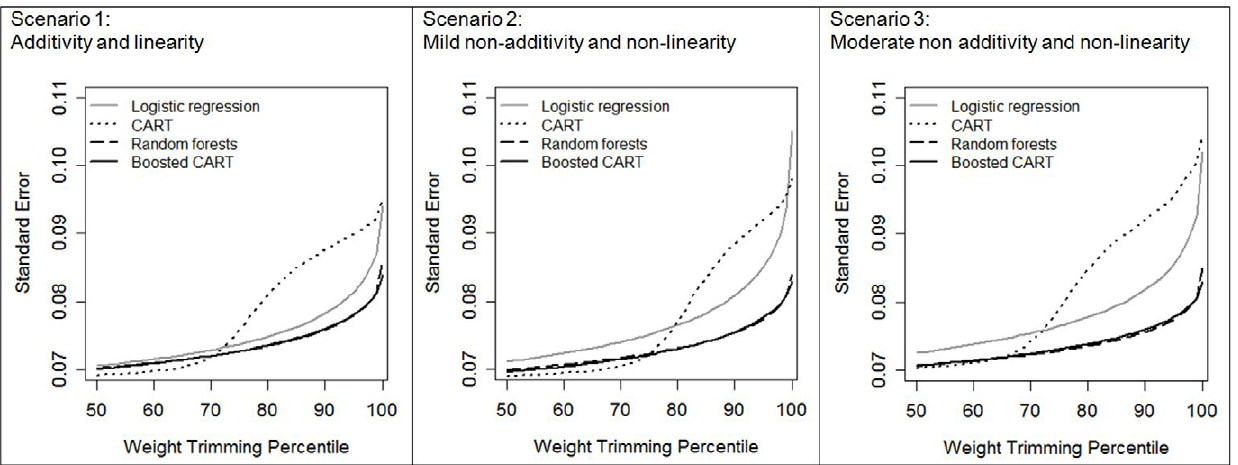
Figure 2. Average standard error in the estimate of treatment effect after propensity score weight trimming for 1000 simulated datasets of N=500, by propensity score estimation method and degree of complexity in the true propensity score model scenario. Scenario 1: additivity and linearity; Scenario 2: mild non-additivity and non-linearity; Scenario 3: moderate non-additivity and non-linearity. The 100th percentile of weight trimming indicates no trimming was